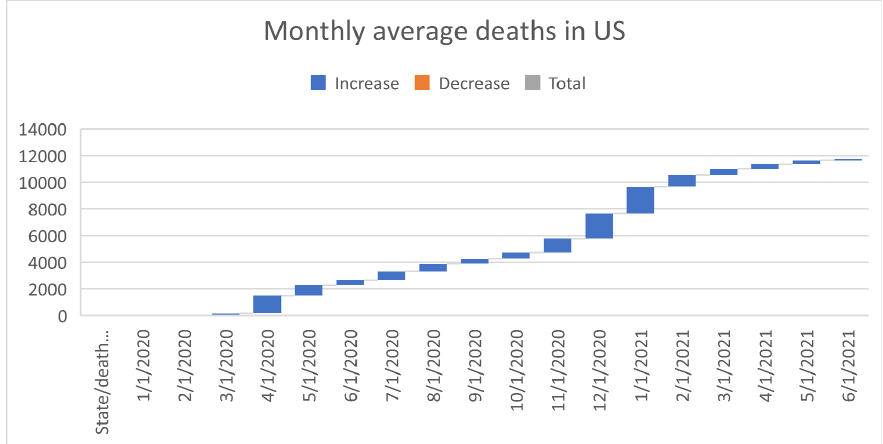
Figure 10. Progressive average number of deaths in US. For readability, note that 4/1/2020 refers 1 April 2020.